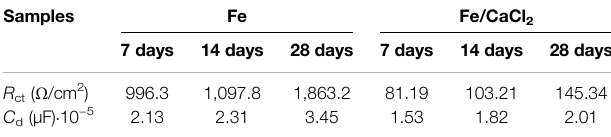
TABLE 1 | Fitted parameters of EIS data for Fe/CaCl 2 composite and Fe. Samples Fe Fe/CaCl